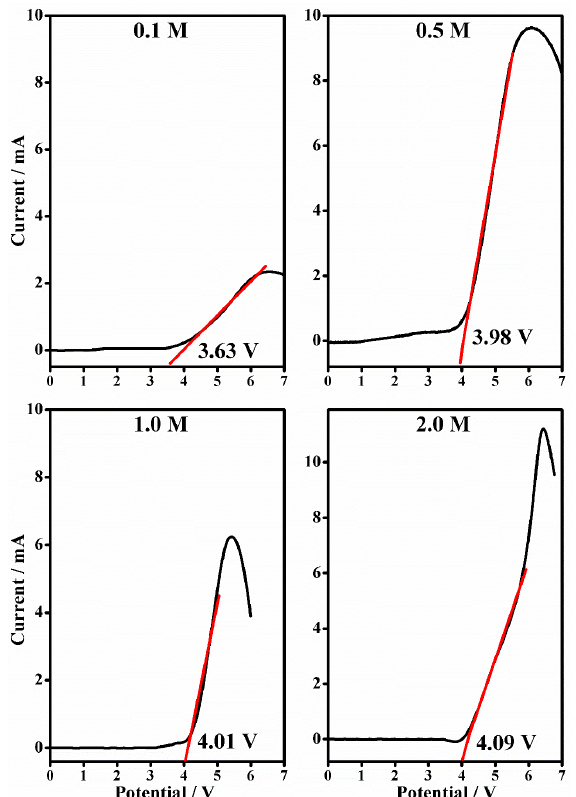
Figure 15. The Linear sweep voltammetry (black line) from 0 to 7 V and in the current range between 0 and 200 mA (scan rate 10 mV/s) and the anodic stability (relative linear fit, red line) of PMMA-Li-